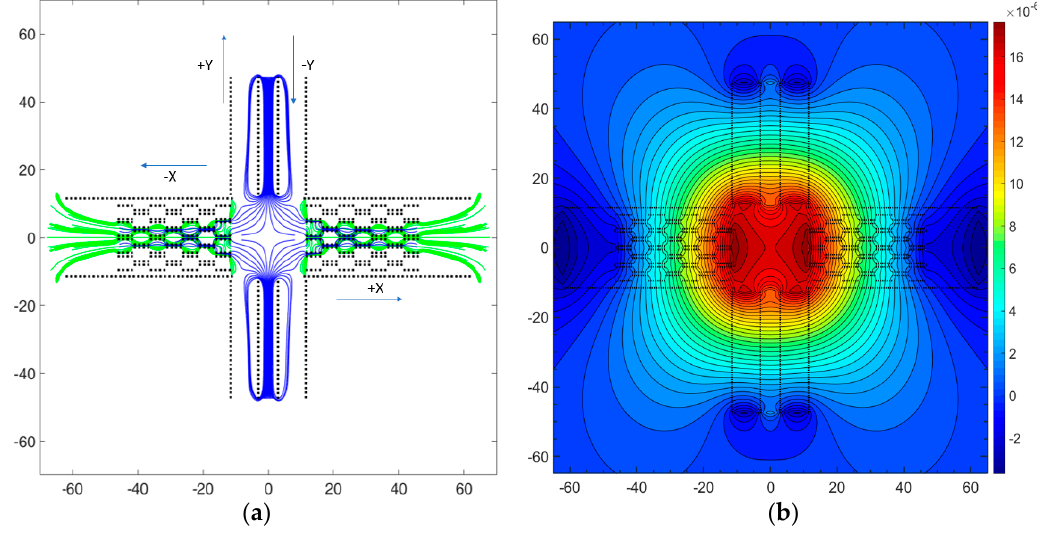
Figure 12. Overbalanced pressure while drilling. ( a ) Blue streamlines are for circulating drilling mud. Formation fluid cannot move into the annulus die to overbalanced drilling, but drilling fluid can invade the reservoir pore space. Green streamlines are for fluid originally in the penetrated formation, which is displaced deeper into the formation space due to drilling mud pressure excess (overbalance). Flow field is solved using a stream function describing the composite flow field. ( b ) Pressure field obtained by solving the corresponding potential function scaled in units of cm 2 s − 1 (Case 6, Table 1). Length units are scaled in cm (both x-axis and y-axis).